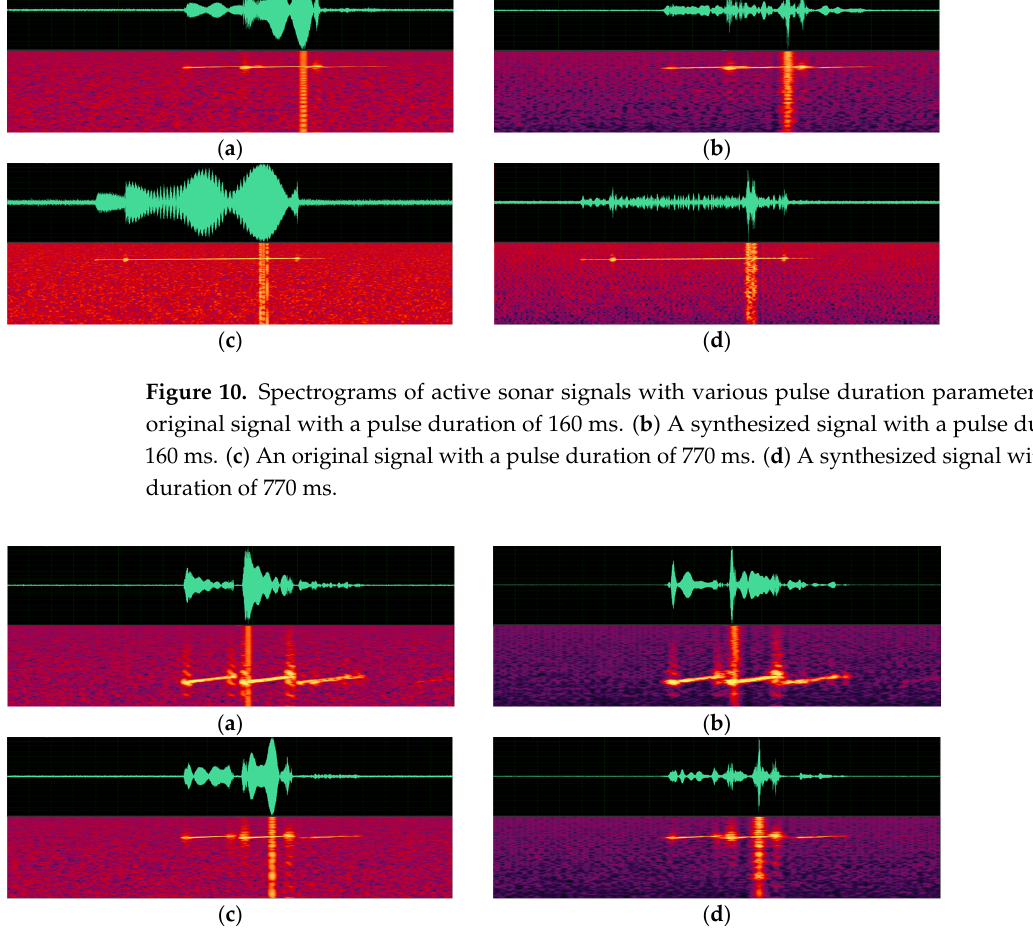
Figure 11. Spectrograms of active sonar signals with various pulse center frequency parameters. ( a ) An original signal with a pulse center frequency of 2080 Hz. ( b ) A synthesized signal with a pulse center frequency of 2080 Hz. ( c ) An original signal with a pulse center frequency of 5920 Hz. ( d ) A synthesized signal with a pulse center frequency of 5920 Hz.